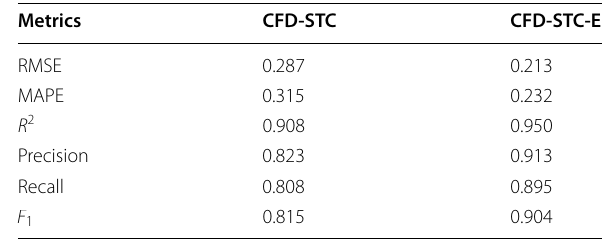
Table 5 Three methods to detect the effect of container cascade fault